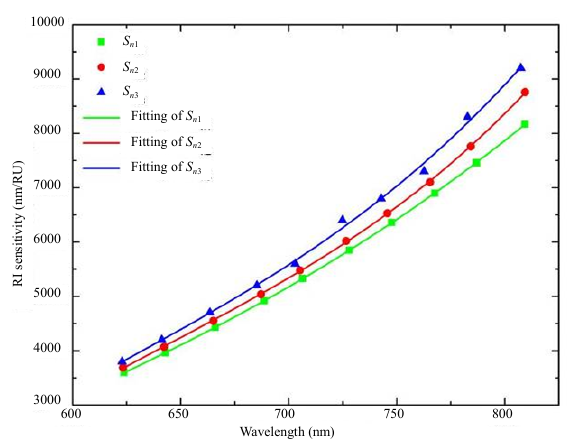
Fig. 8 Fitted curves for the RI sensitivity of the resonant wavelength